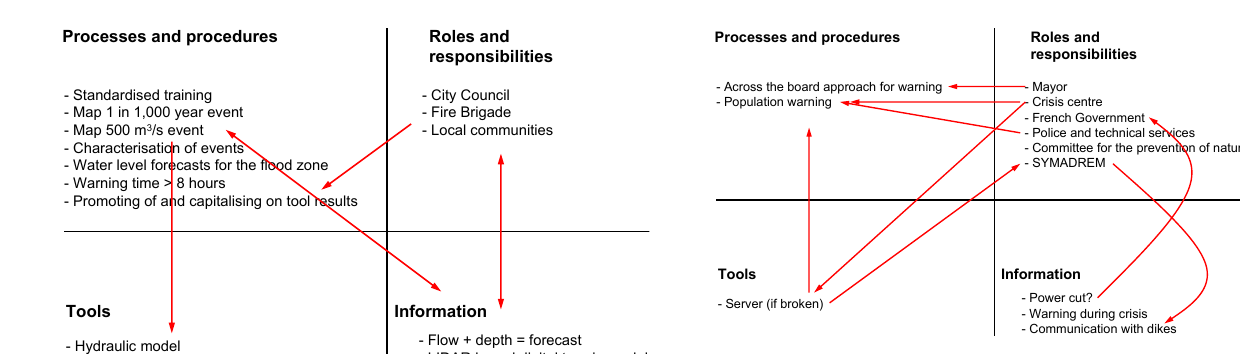
Fig. 9. Cross-table for “flood warning” for Tarascon, developed during the